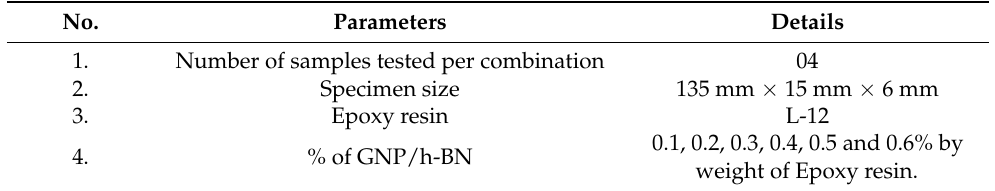
Table 5. Sample Characteristics (Flexural Test).